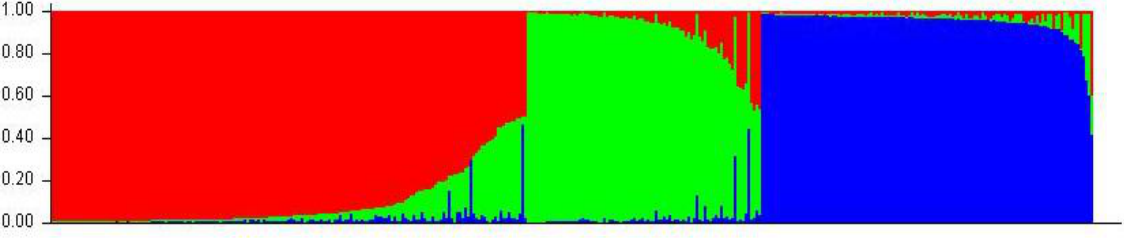
Figure 3. Genetic structure among the 383 cherry genotypes/cultivars based on 16 SSR markers. Each genotype is represented by a vertical bar partitioned into three genetic clusters ( K = 3). Each color represents the estimated membership fraction of the three genetic clusters (cluster 1 = red; cluster 2 = green, cluster 3 = blue).